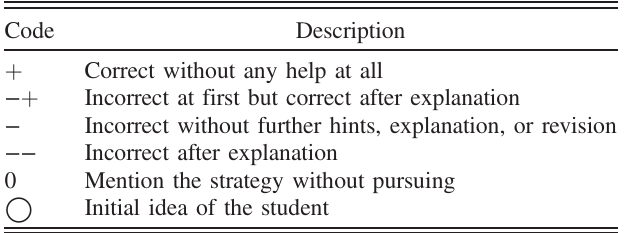
TABLE I. The coding scheme used to analyze the correctness of student answers to the questions in Sec. III